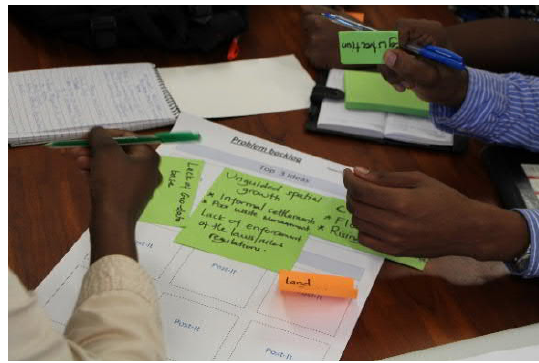
Figure 7. Two-phased innovation workshop aimed at training participants with location-based smart city solutions in Tanzania (May 2017).